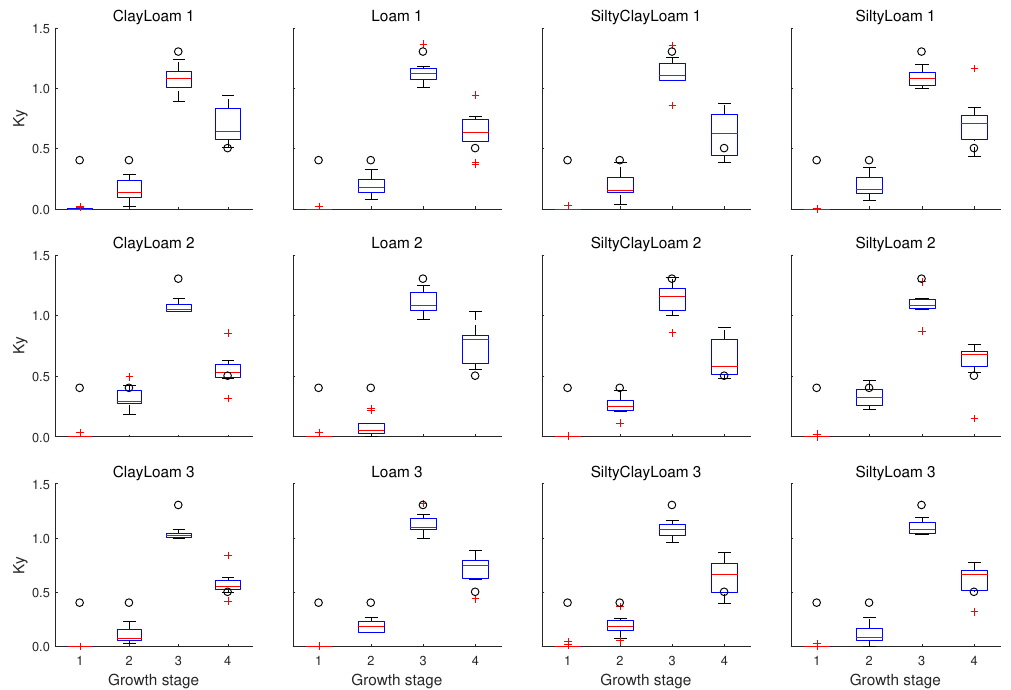
Figure 5. Yield response factor ( Ky ) obtained for maize for every soil type, considering the benchmark process. Circles represent Ky values proposed by the FAO [51].